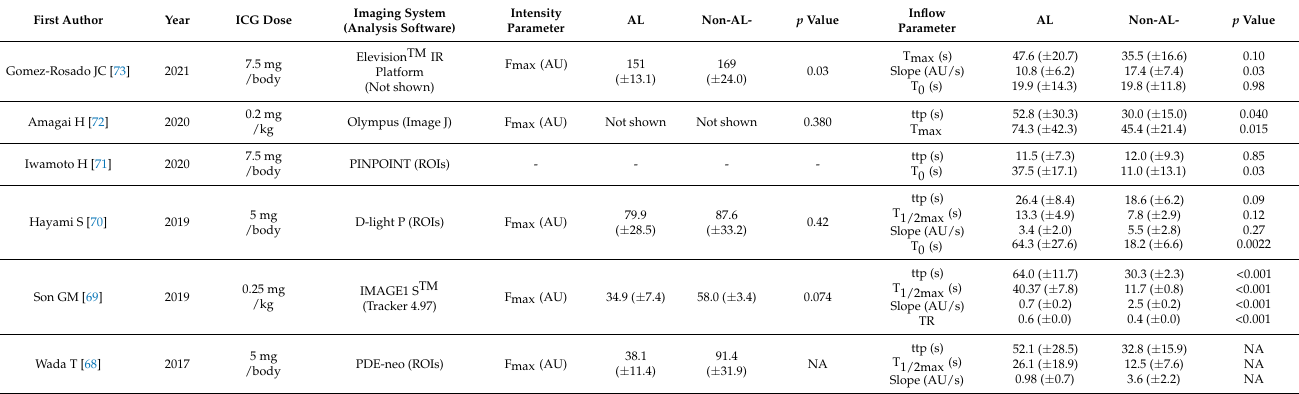
Table 2. Summary of clinical studies with quantitative assessment of ICG-FA.